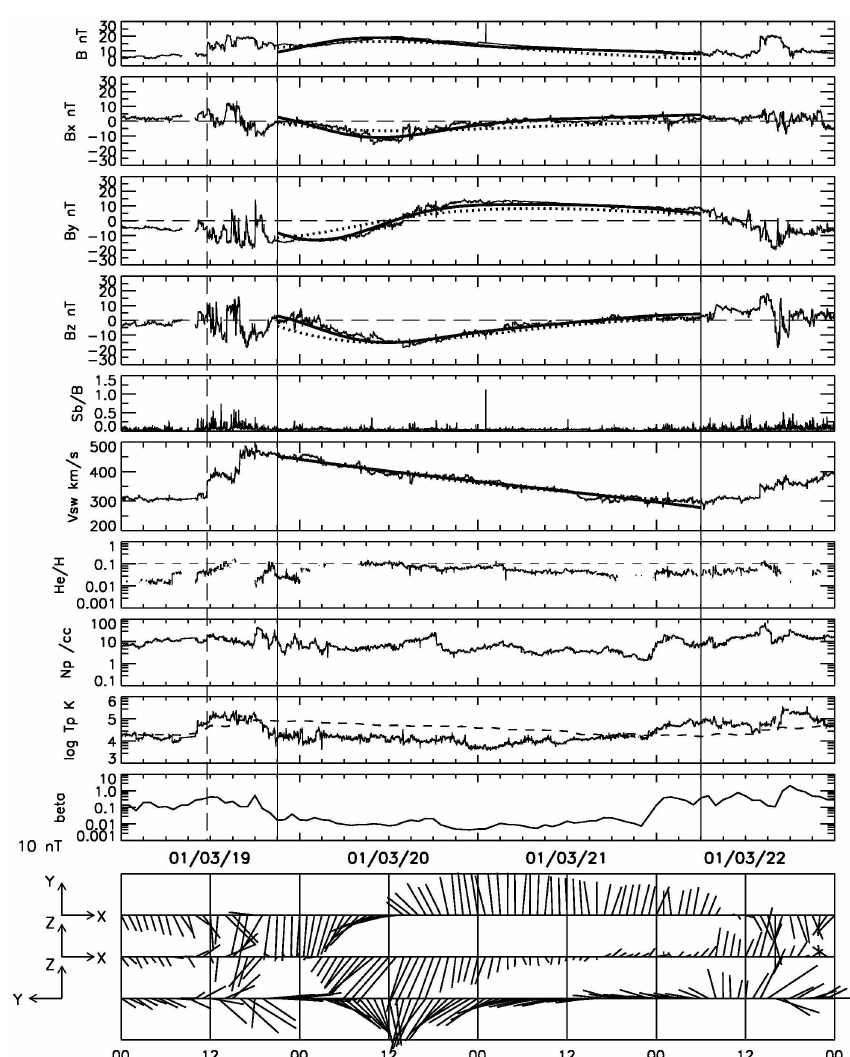
Fig. 4. Results of the fitting with the torus model (solid line) and with the cylinder model (dotted lines) to the magnetic cloud (Event No. 13) encountered on 19 March 2001 superimposed on the data plots of the observed solar wind parameters. The two vertical solid lines indicate the MC boundaries, and the vertical dashed line indicates the shock arrival time. The bottom three panels show the projected magnetic field vectors.